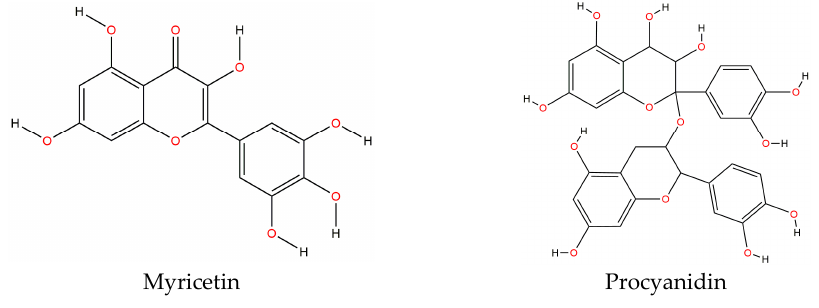
Figure 2. Structures of major flavonoids of P. vulgaris [46].